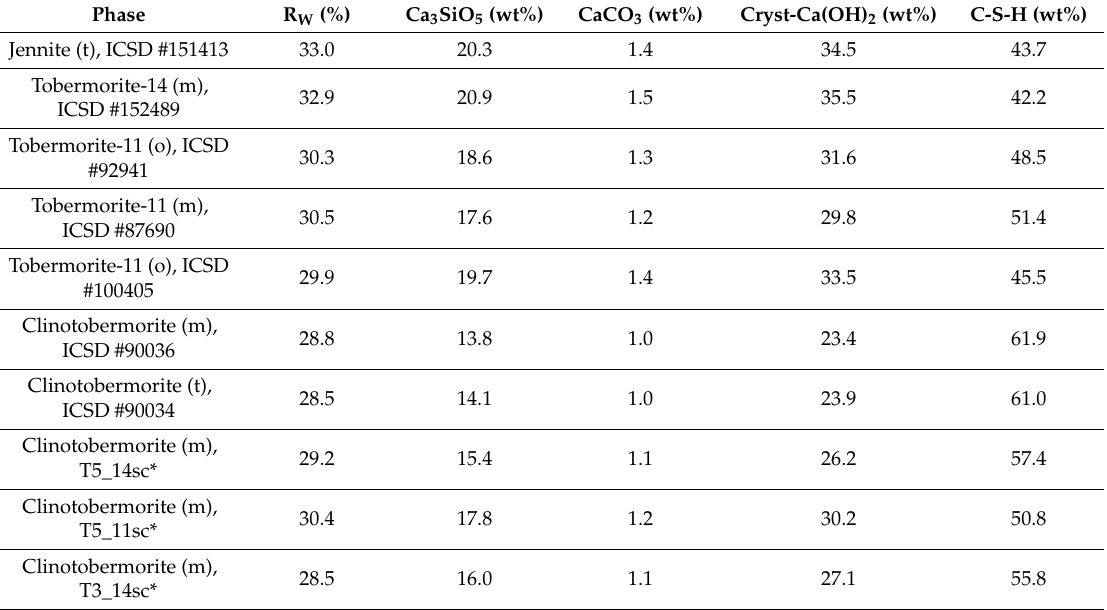
Figure 3. Experimental (blue circles) and fitted (red solid line) PDF for Ca 3 SiO 5 w/s = 0.80 paste in the 40 to 70 Å r-range. Difference curve is shown as a grey line. Table 1. Selected results for the synchrotron PDF analysis of the w/s = 0.80 alite paste in the 10–25 Å r-region, using different structural descriptions for the nanocrystalline C-S-H